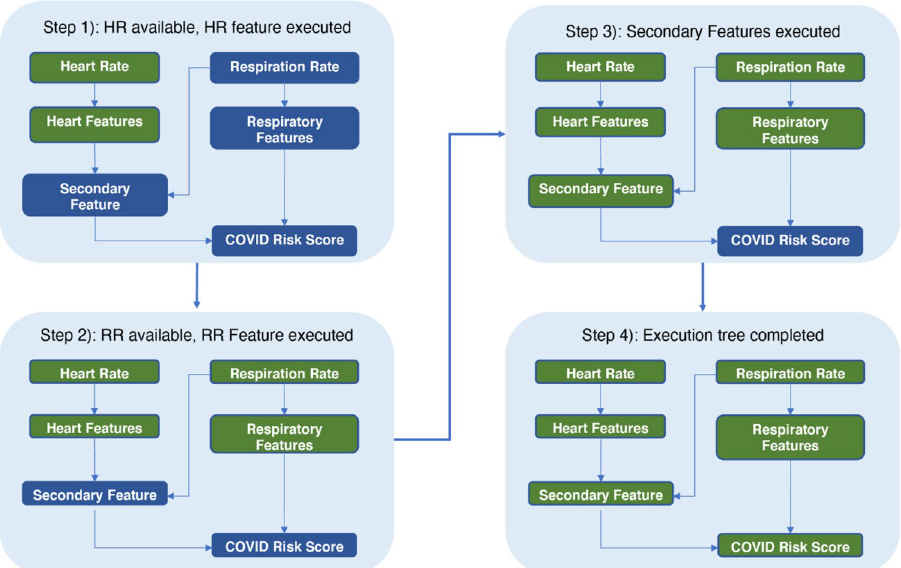
Figure 2. Toy example of the feature pipeline orchestrated by the triggering mechanism on the runtime execution DAG. The trigger maintains the state of the execution graph and its requirements at each step of the process. In this example, the machine learning prediction (COVID risk score) gets first reported as soon as the respiratory feature becomes available. As additional features (e.g., those from heart rate) become available, the prediction is updated with the new